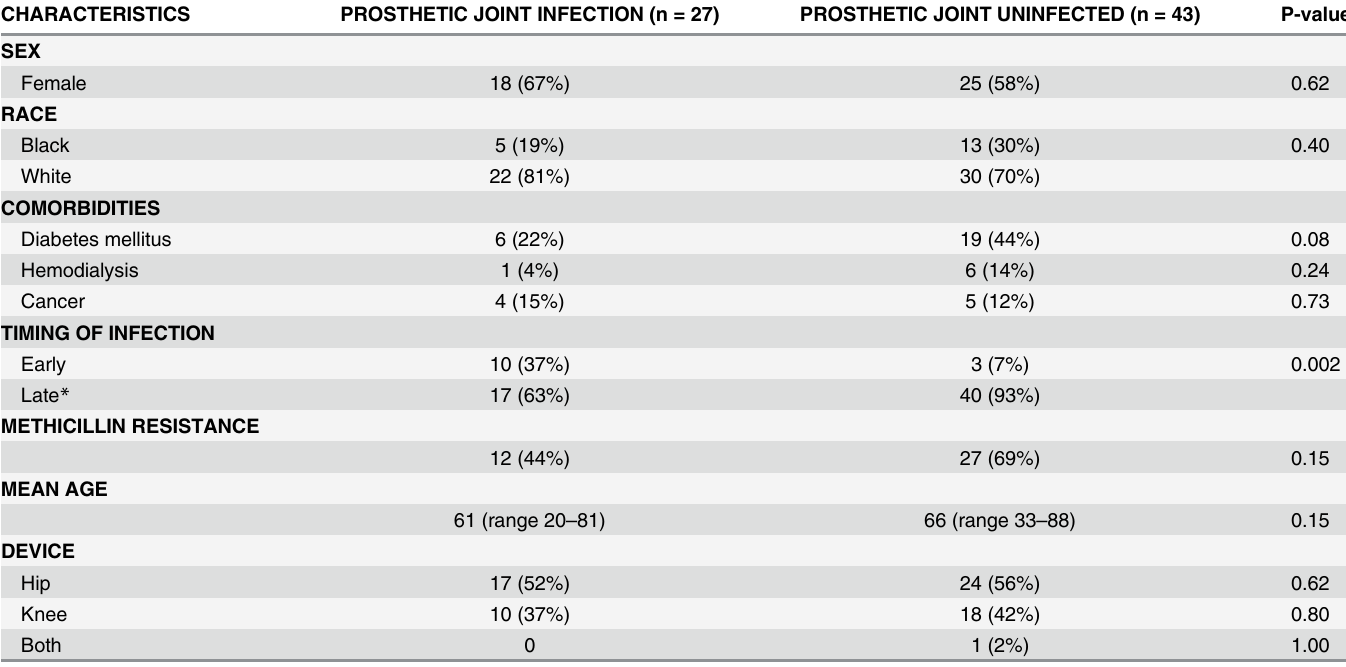
Table 1. Demographic and clinical characteristics of patients in the derivation cohort with S . aureus bacteremia and infected or uninfected prostheses.